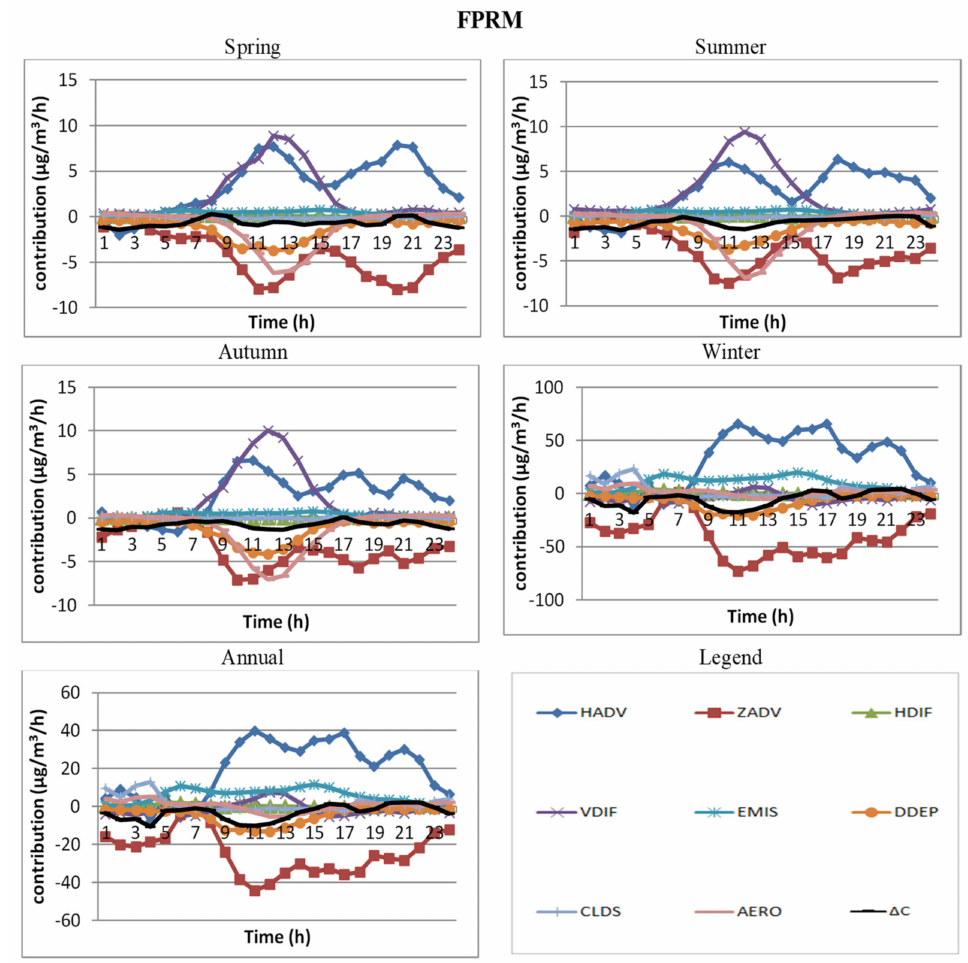
Figure 13. Annual, seasonal and diurnal course of the contribution of the different dynamic and chemical processes to the formation of FPRM concentrations ( µ g/m 3 /h) averaged for Orlov most for the period